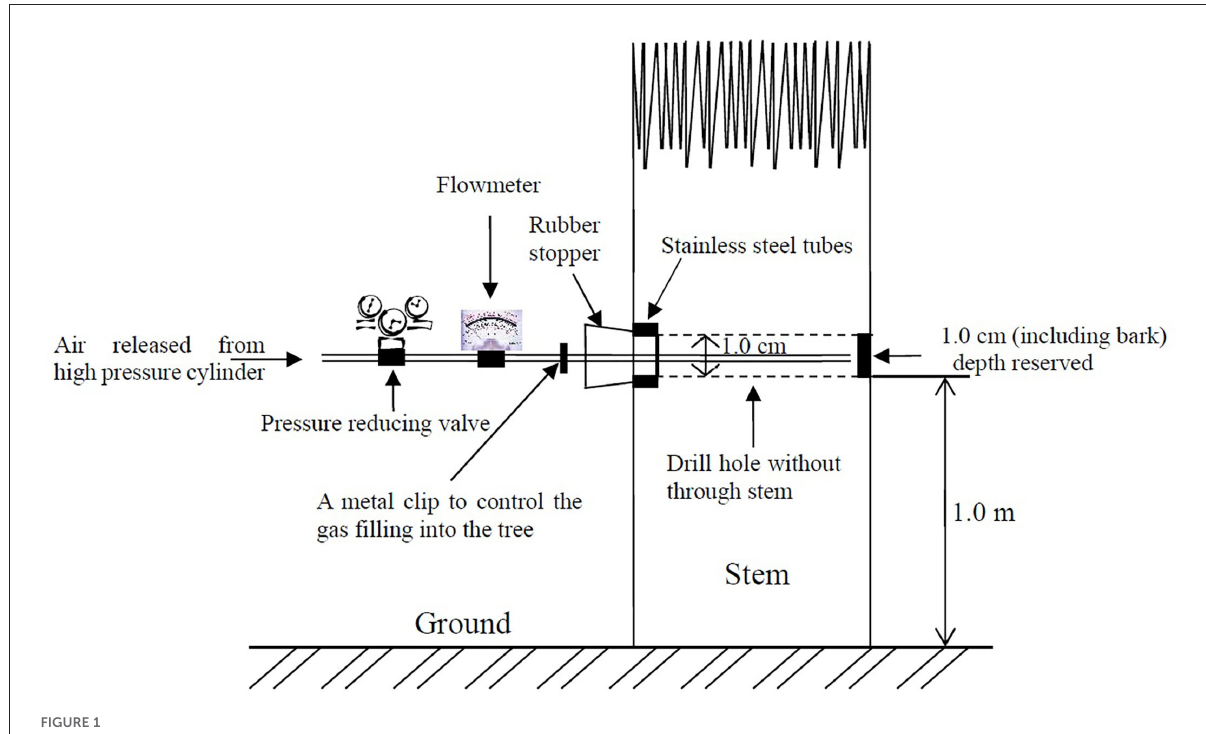
FIGURE1 Schematic map for treatment of sandal with different gases.